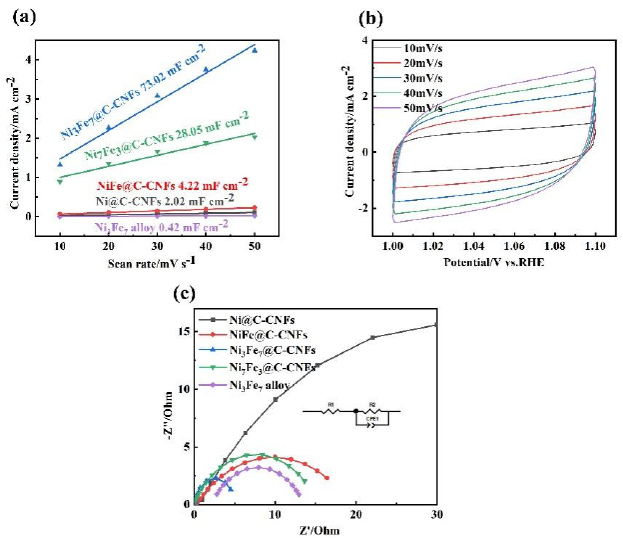
Figure 6. ( a ) Cyclic voltammetry curves of samples; ( b ) ECSA measurements under different treat- ment conditions; ( c ) Nyquist plots.